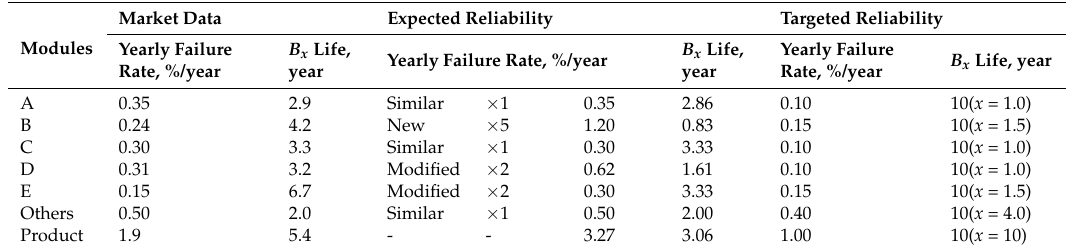
Table 1. Overall parametric accelerated life testing (ALT) plan of a